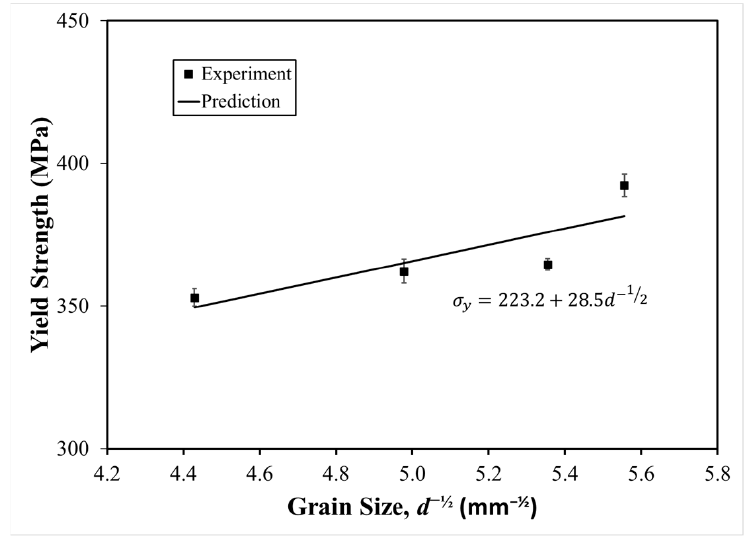
Figure 8. The relationship between yield strength and grain size and its prediction using the Hall– Petch equation.